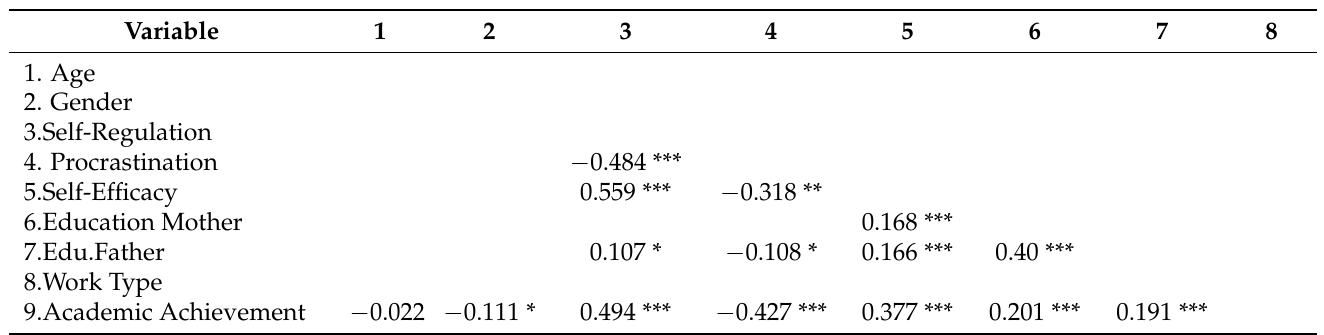
Table 2. Bivariate correlations ( n = 430).